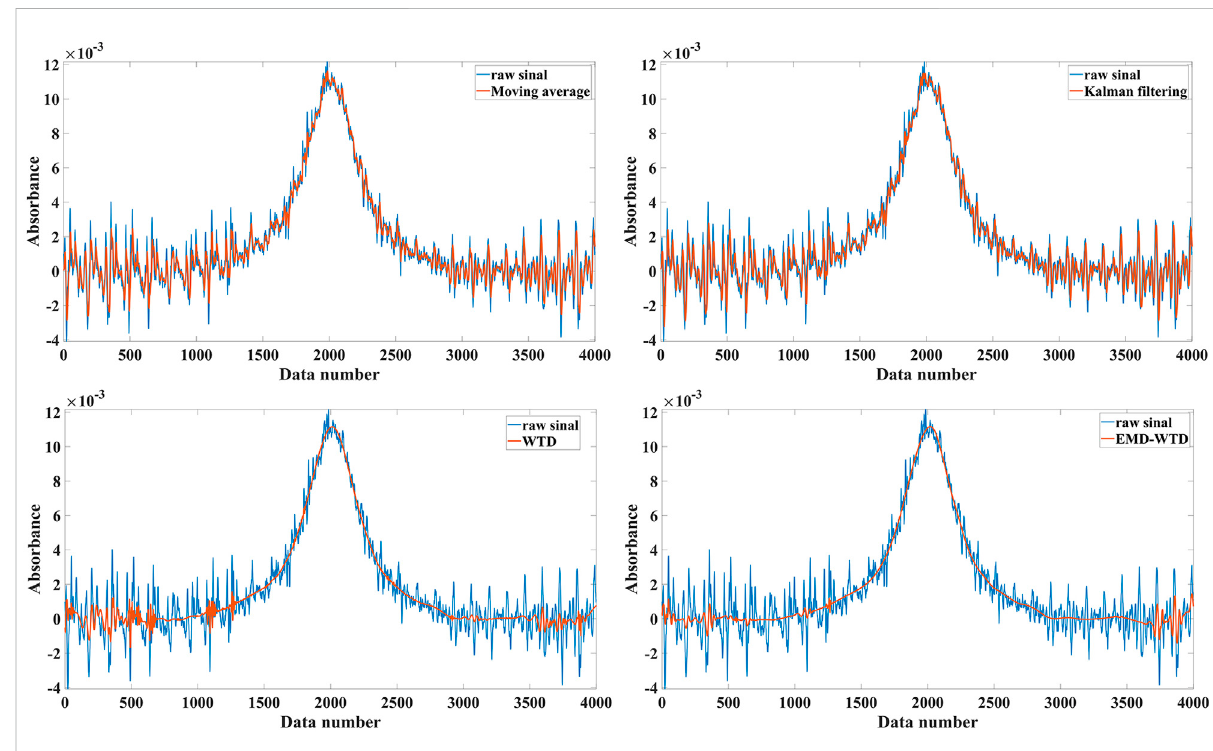
FIGURE 9 DAS signal of CO 2 detected in the experiment and the denoising result by using moving average, Kalman fi ltering, WTD and